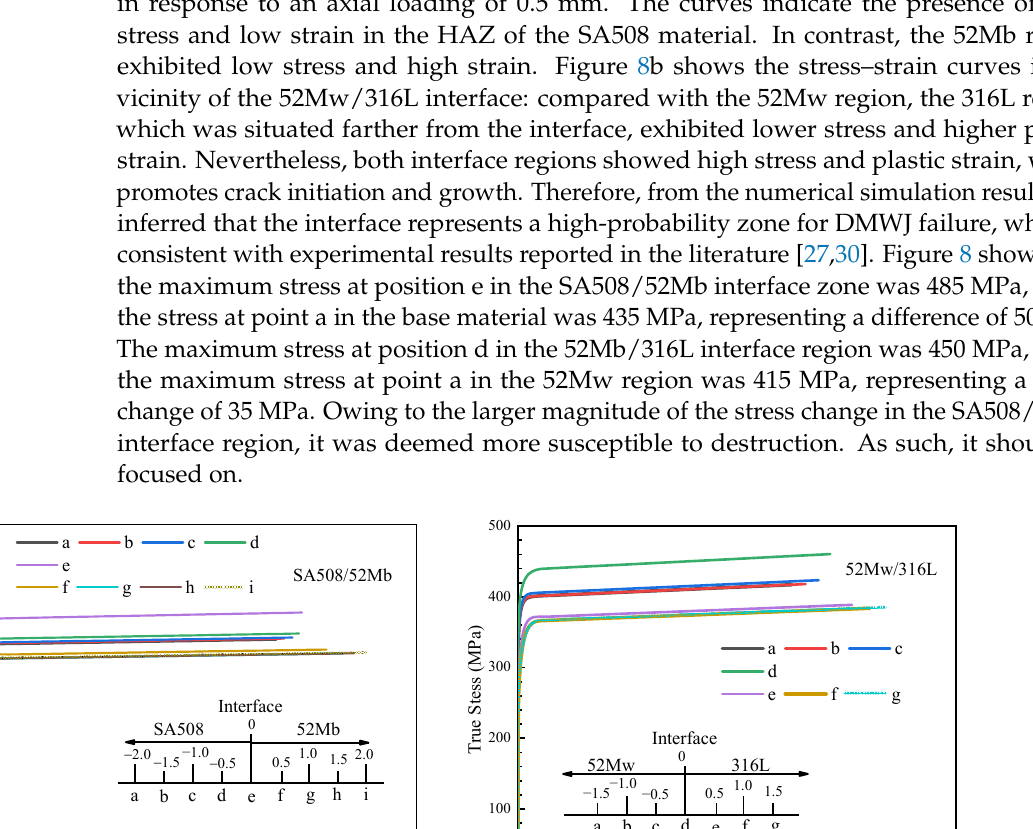
Figure 7. Numerical simulation results under the simultaneous action of axial load and internal pressure: ( a ) continuous transition model, ( b ) sandwich model.